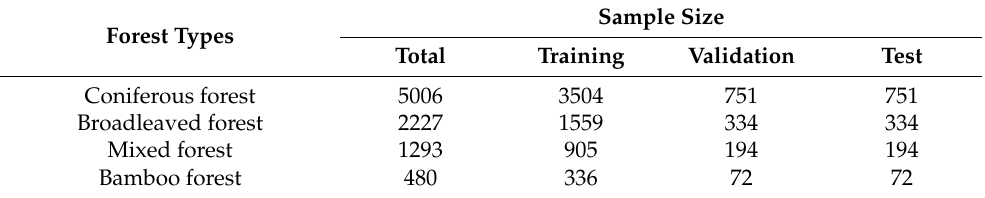
Table 5. Sample sizes of vegetation carbon storage inversion models across different forest types.